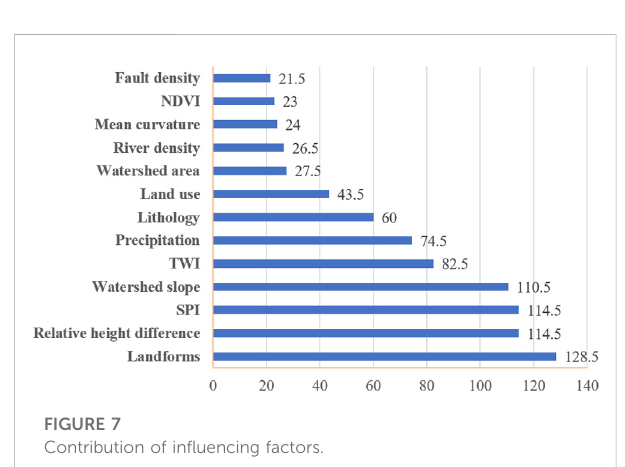
FIGURE 7 Contribution of in fl uencing